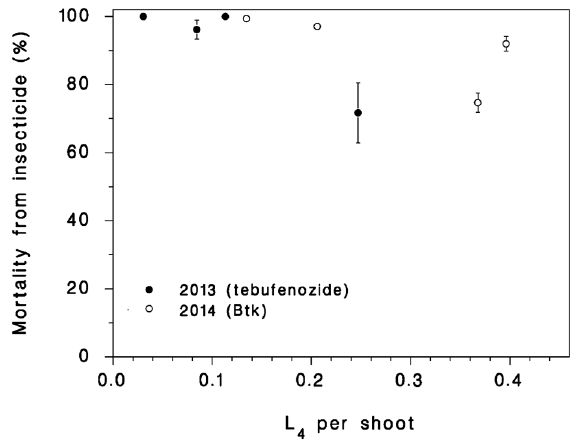
Figure 4. Mortality directly attributable to insecticides, as calculated with Equation (10). Vertical bars: SEM.